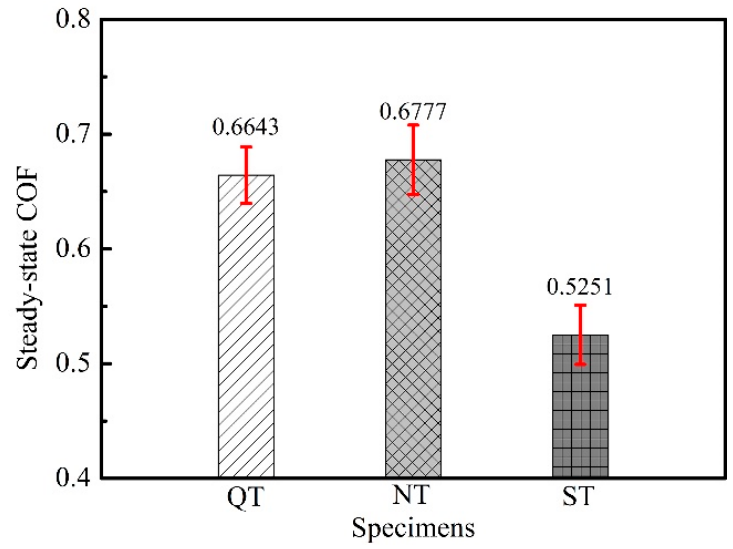
Figure 9. The average steady-state COF at the midpoint of the wear track.